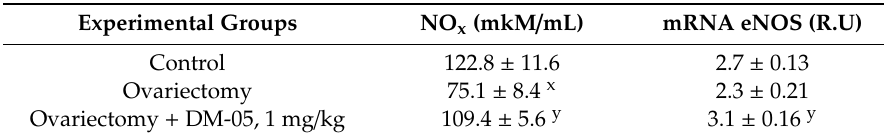
Table 2. Values of NO x and mRNA eNOS in animal groups with hypoestrogen-induced endothelial dysfunction and its correction by furostanol glycosides from Dioscorea deltoidea cell culture (M ± m; n = 10).